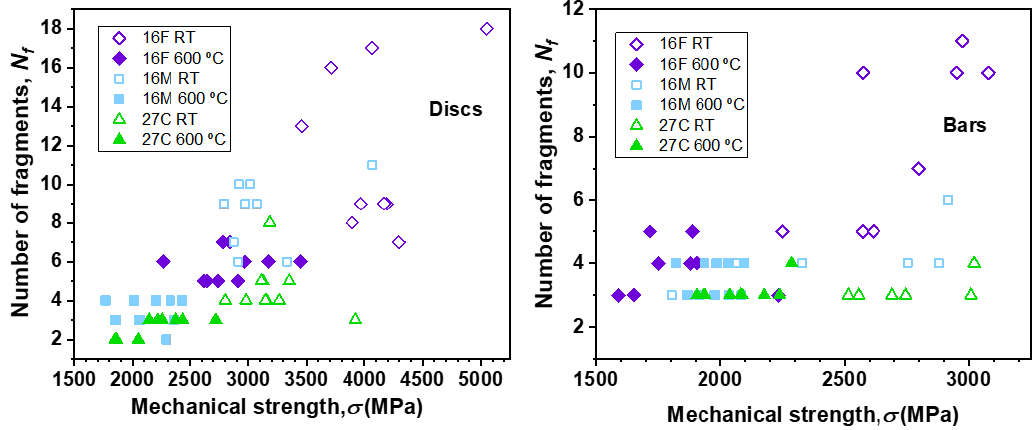
Figure 3. Relationship between the number of fragments ( N f ) in the broken samples from the B3B and 4PB tests and the mechanical strength ( σ ).